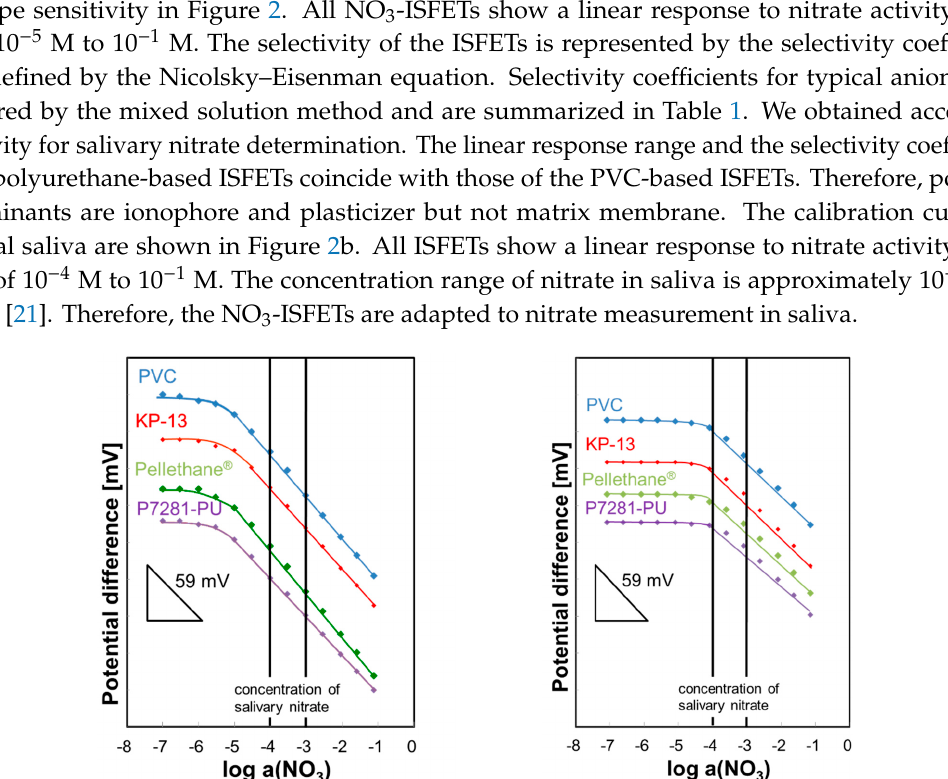
Figure 1. pH-sensitive ion-selective field-effect transistors (pH-ISFETs) and accessory cap.